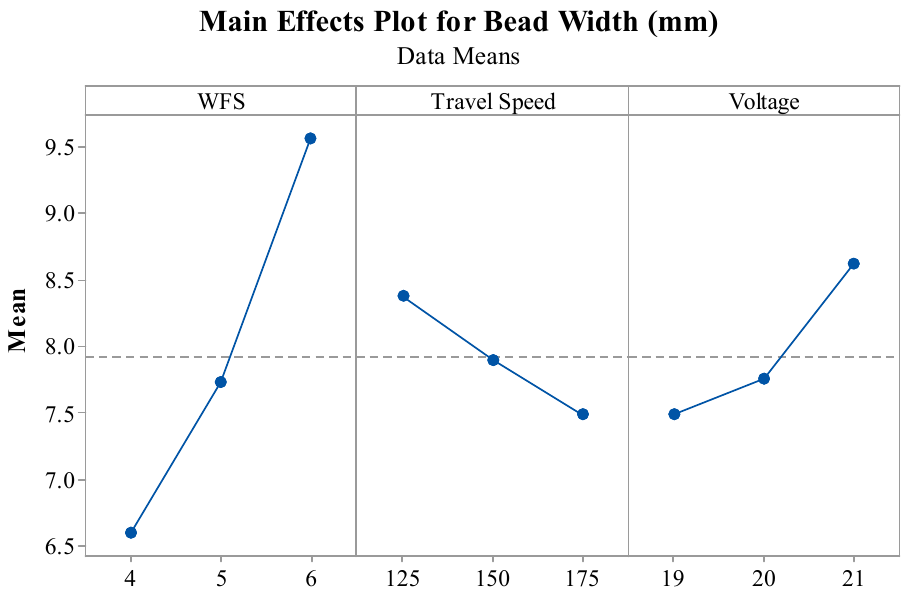
Figure 6. Normal probability plot for bead height.